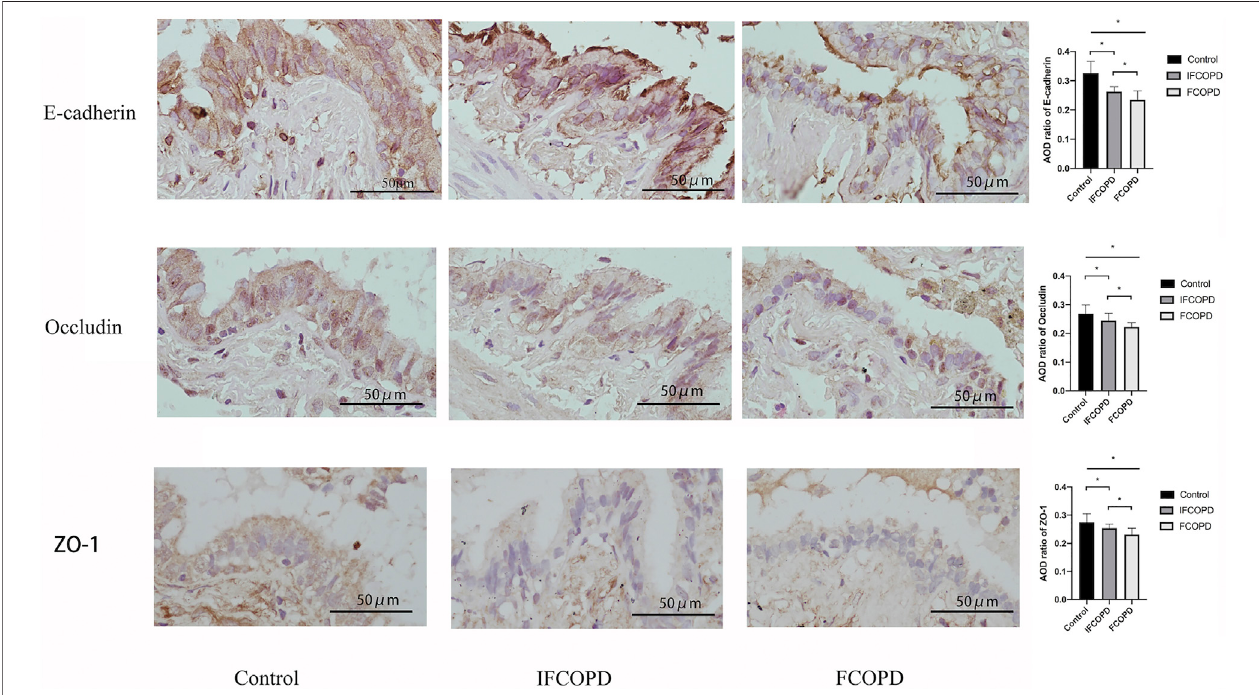
FIGURE 2 | Immunohistochemical analysis of E-cadherin, occludin, and ZO-1 expression in the airway epithelium cells of Control (n (cid:1) 15), IFCOPD (n (cid:1) 18), and FCOPD (n (cid:1) 8) groups. The control group included subjects with normal lung function and a current smoking history of > 10 pack years. Cells were stained with anti-E- cadherin, anti-occludin, and anti-ZO-1 antibody. All subjects were determined by IHC (400 × ). Data are displayed as mean ± SD, * p < 0.05 by one-way ANOVA. Results represent signi fi cant differences in the expression of E-cadherin, occludin, and ZO-1 in airway epithelium cells, compared to the Control group.